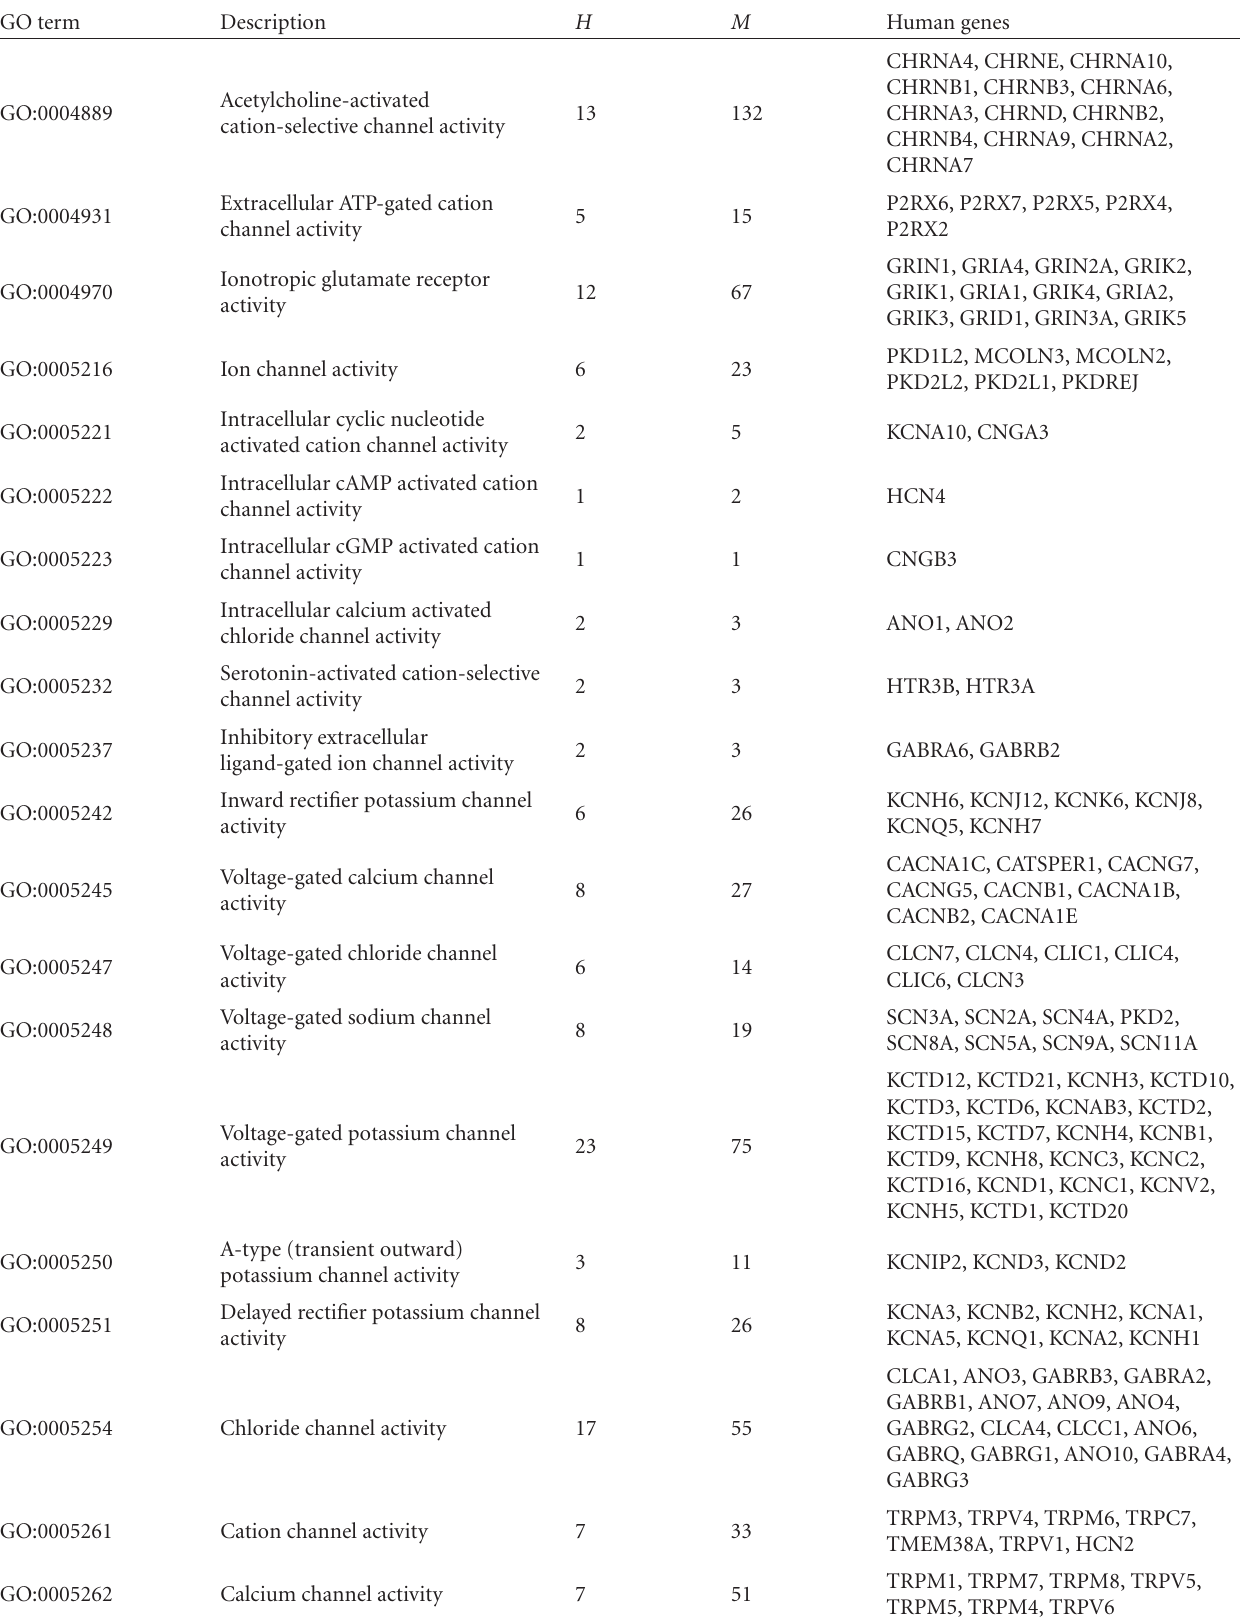
Table 2: Major categories of ion channel genes conserved between H. sapiens and M.